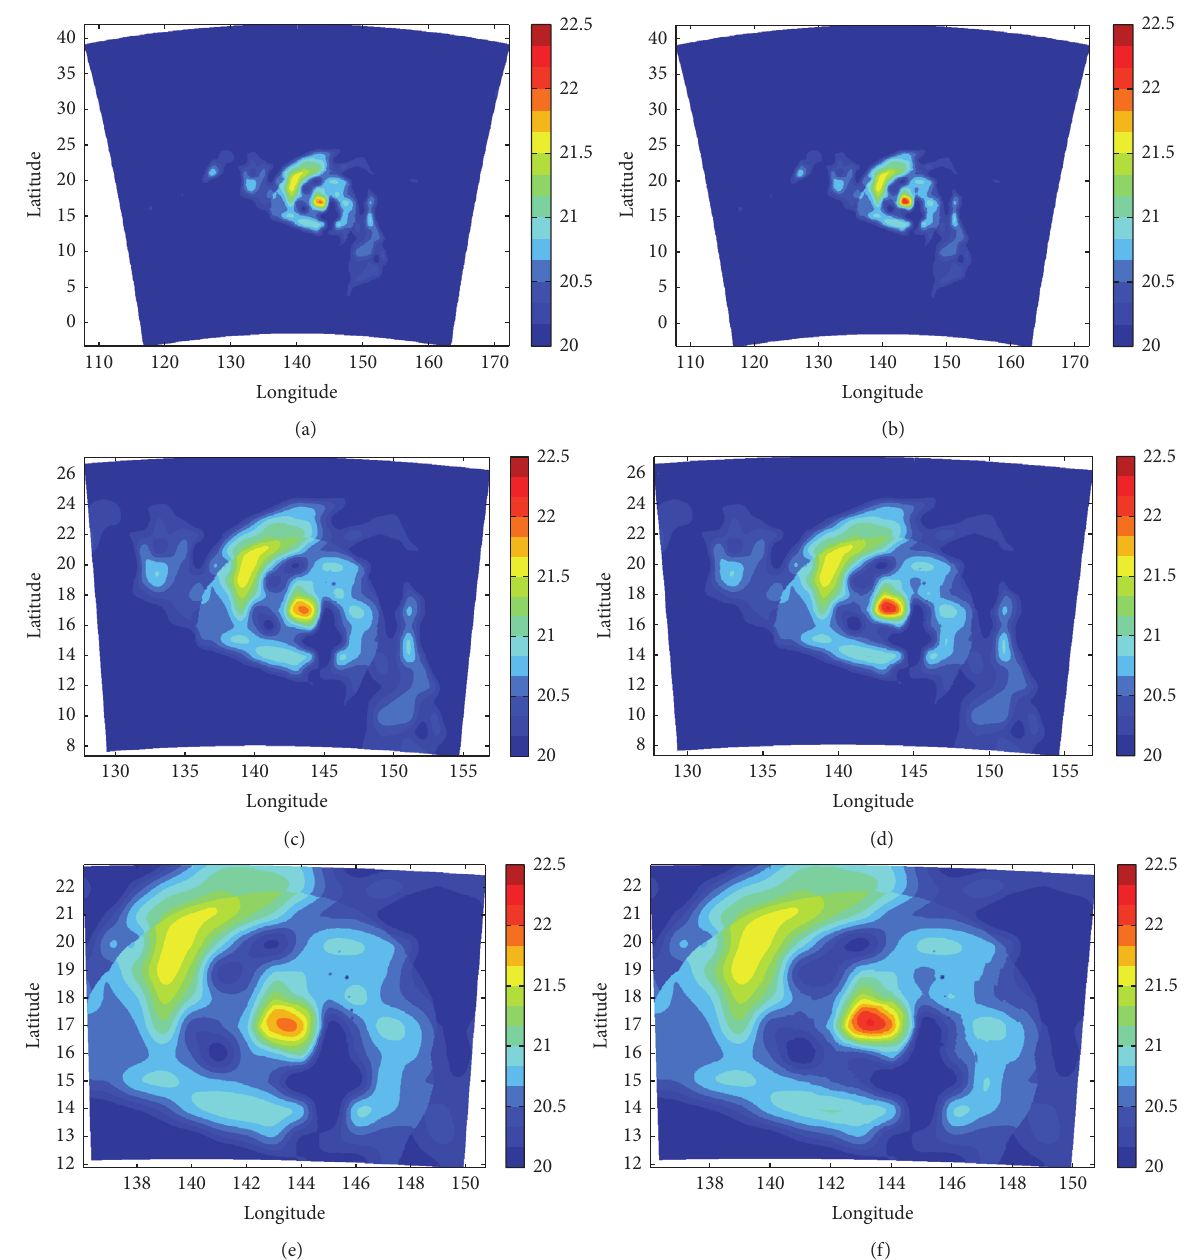
Figure 4: Phanfone: (a) 𝑞 𝑠 before initialization in D01 (27 km); (b) 𝑞 𝑠 after initialization in D01 (27km); (c) 𝑞 𝑠 before initialization in D02 (9km); (d) 𝑞 𝑠 after initialization in D02 (9km); (e) 𝑞 𝑠 before initialization in D03 (3 km); and (f) 𝑞 𝑠 after initialization in D03 (3km). The unit in these figures is